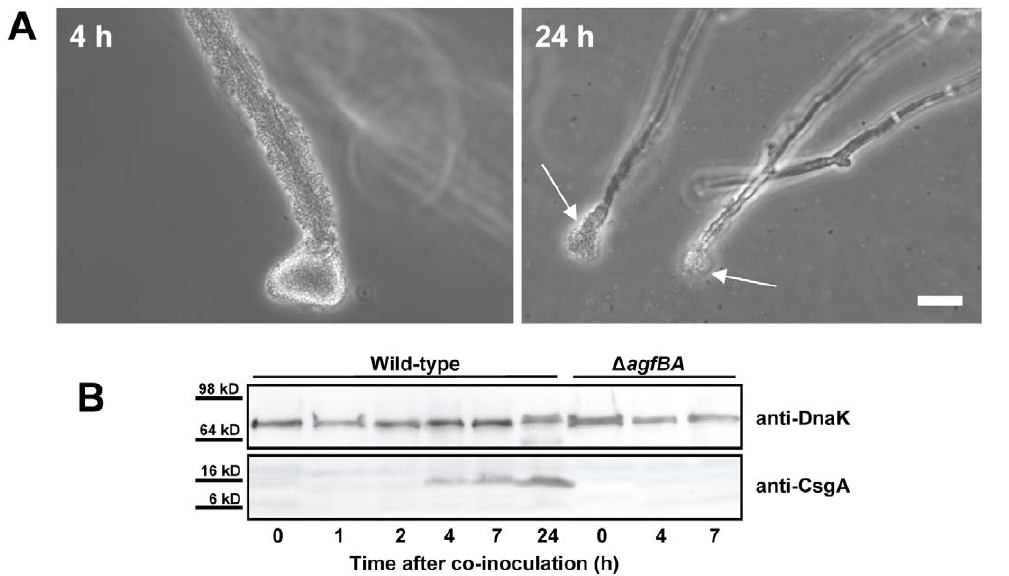
Figure 5. Role of curli in the interaction of S . Typhimurium with A.niger . (A) Colonization of the hyphae by a S. Typhimurium mutant deficient in curli fimbriae production ( D agfBA ). Note that the 4 h-biofilm formed by this mutant is thick and very similar to the WT biofilm shown in figure 1C. By 24 h, the mutant remains on the hyphae mostly at their tips (long white arrows) compared with the WT, which persists as a biofilm along the entire A. niger hyphal surface, as shown in figure 1E. (B) Whole-cell Western blot analysis of curli production by S . Typhimurium wild-type and its AgfBA-minus mutant during biofilm production on A. niger . The blot was probed with anti-DnaK antibody as an internal control (top panel) and with anti- E. coli CsgA antibody (lower panel), which also binds to AgfA. The time (h) of sampling during co-incubation is given under the lower panel. Samples at 0 h were obtained from S . Typhimurium inoculum cells grown in LB broth at 28 u C. Curli were not detected in the whole-cell lysates of the D agfBA mutant at 24 h. Scale bar, 20 m m.